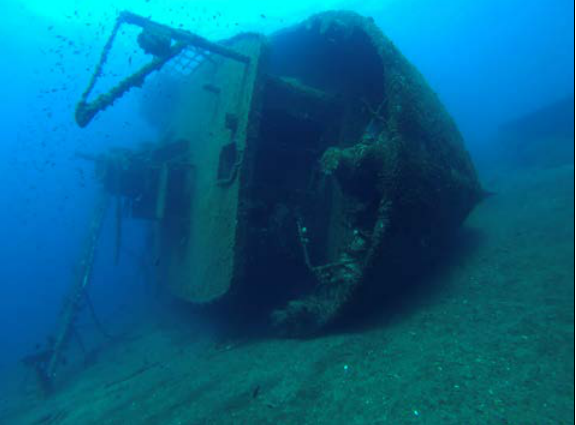
Figure 3. The stern part of the shipwreck lies on its side over a sandy bottom at the depth of approximately 17